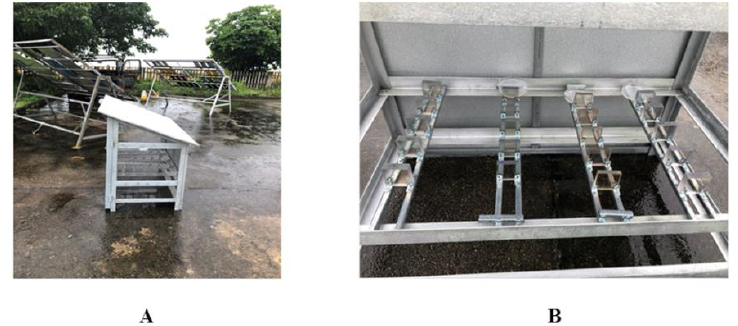
Figure 2. The placement of samples at the testing station, Tropical Center, Nha Trang, Vietnam. ( A )—concrete platform with installations for placing organic glass samples; ( B )—installation with placed samples.